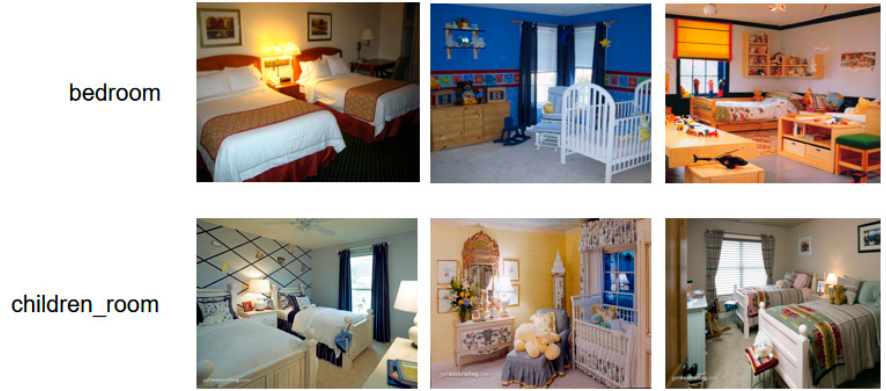
Figure 2. Images of two categories from the MIT indoor 67 dataset. Each row shows the difference within the class. Each column shows the similarity between classes.